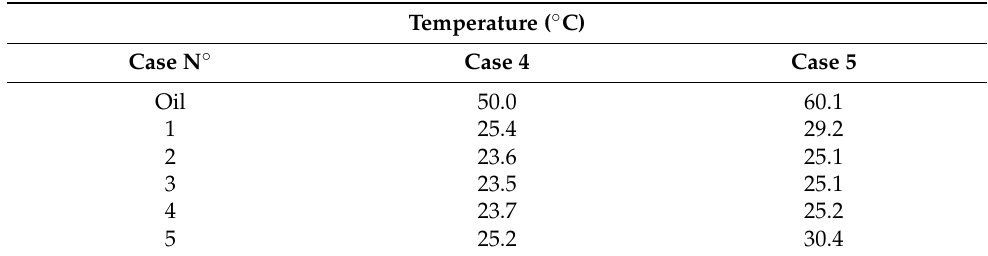
Table 3. Measurement of the bushing temperature at various points to check for non-uniform temperature distribution; the markings of the measurement points are as shown in Figure 4a.